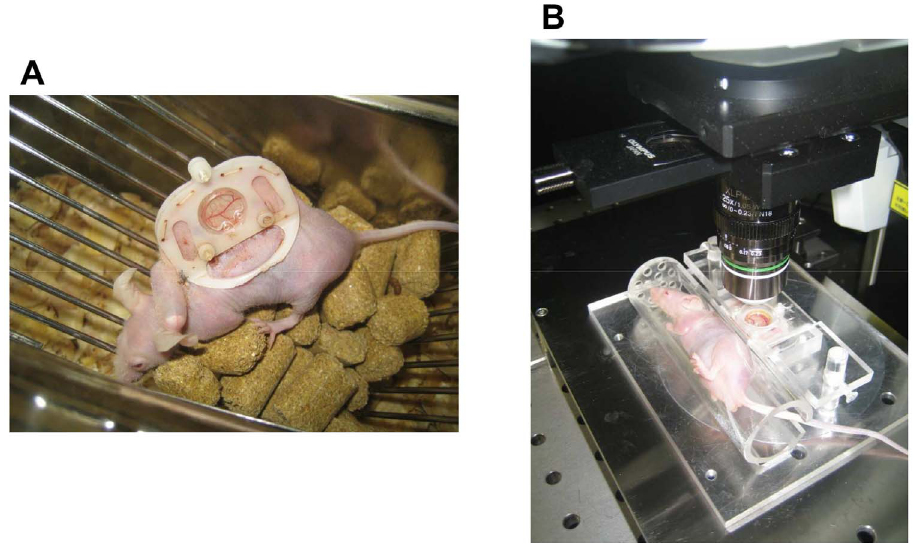
Figure 1. Mice bearing the dorsal skinfold chamber (A). Mice during microscopic observation (B). The mice were positioned in an acrylic resin tube during microscopic observation. The tube was fixed on an acrylic resin plate and then placed on the microscope